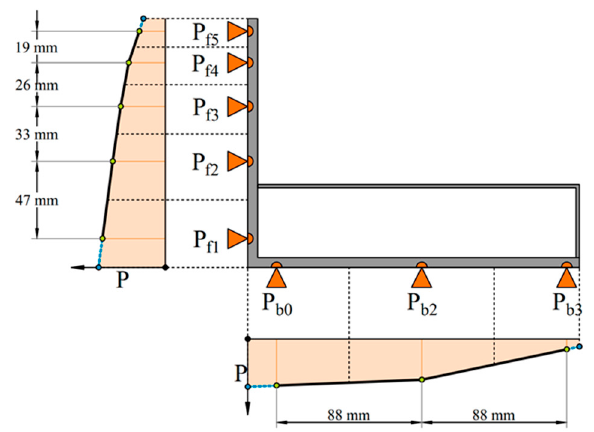
Figure 5. Pressure integration principle [5].